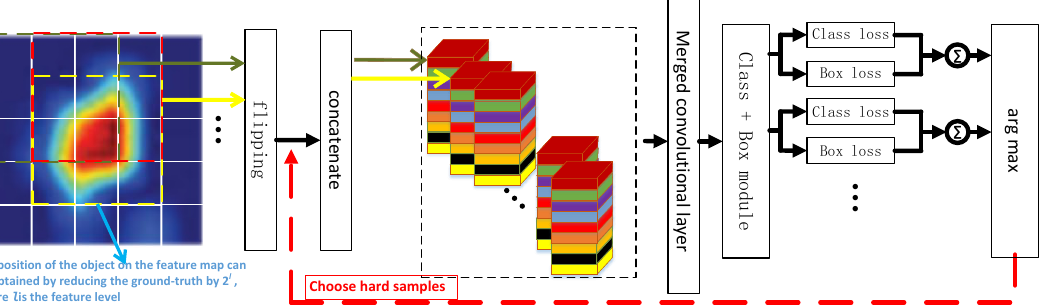
Figure 8. Online deformable sample creation module. Each sample passed through the CBAF module to compute the focal loss and smooth L 1 loss. Then, the level with the largest sum of the two losses is selected as the supervision signal for hard